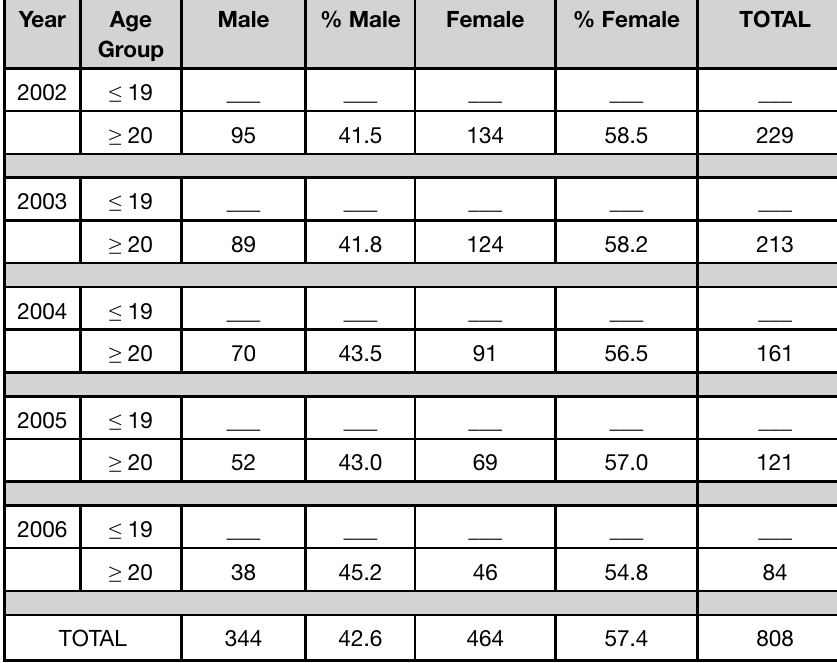
Table 2: Attendance at the Stress Management and Health Promotion Clinics between January 2002 and December 2006